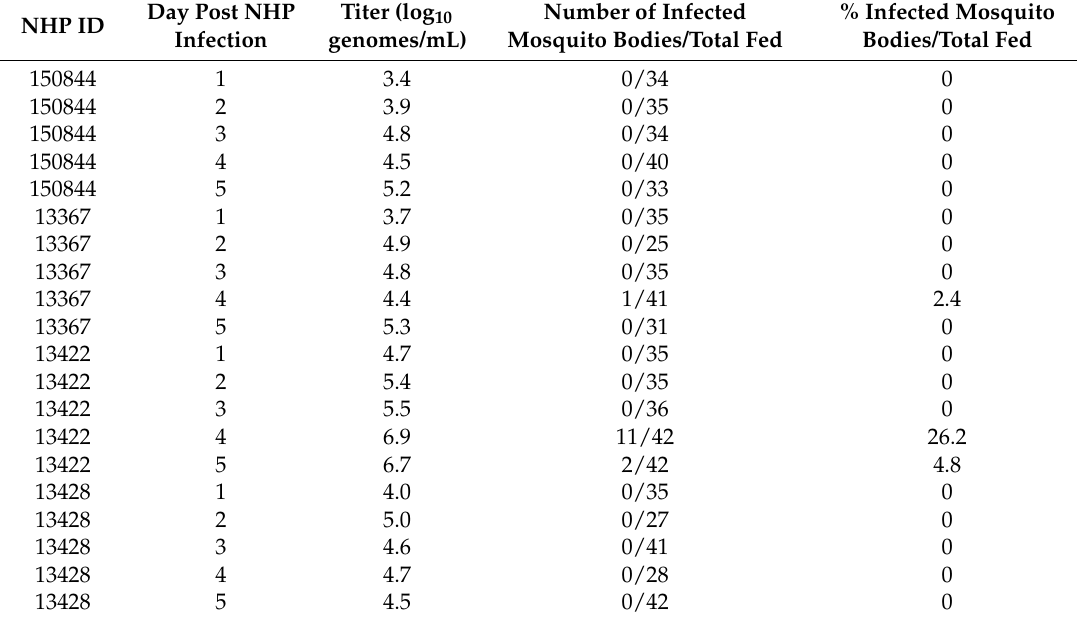
Table 1. Mosquito infectivity of viremic cynomolgus